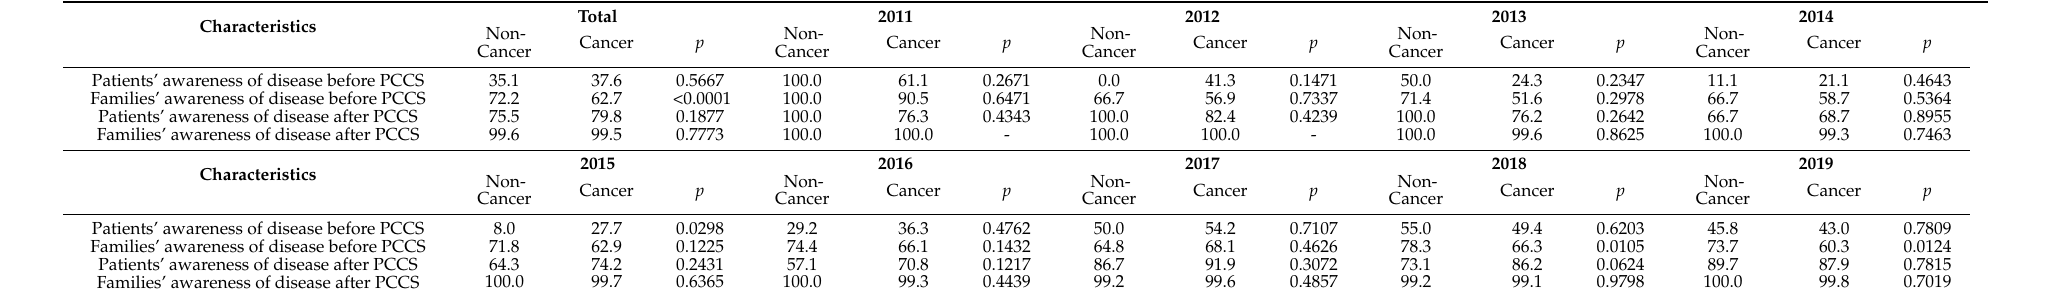
Table 2. Awareness of disease among patients and family before and after